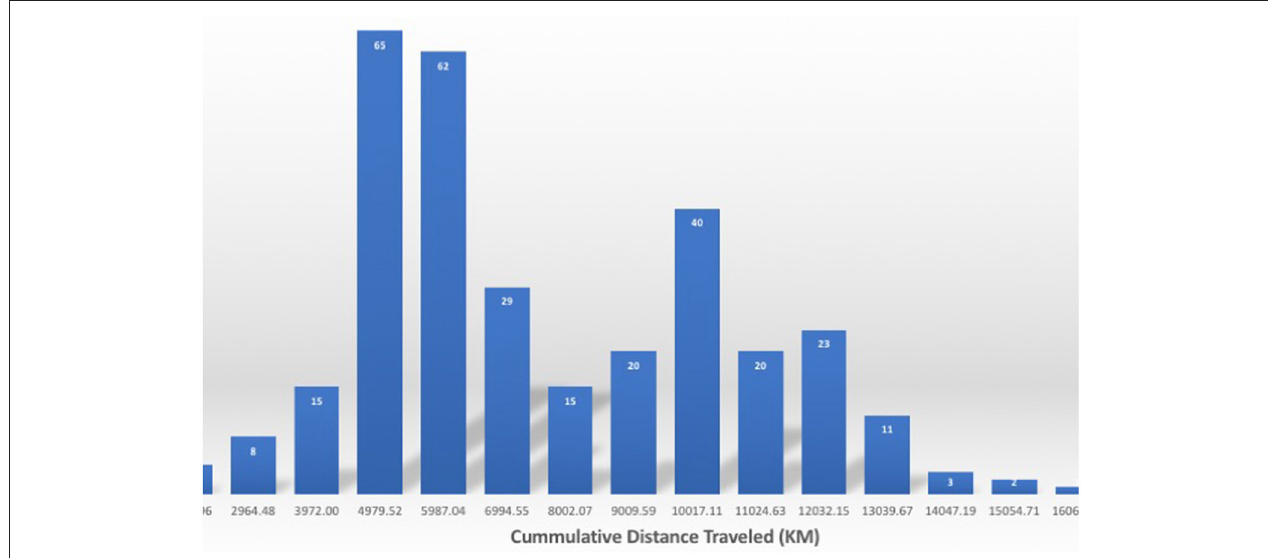
FIGURE 7 | Frequency distribution of the cumulative distance traveled by the northern elephant seals along the Northeastern Pacific Ocean. Numbers on the columns in white indicate the number of individuals performing a migration of that